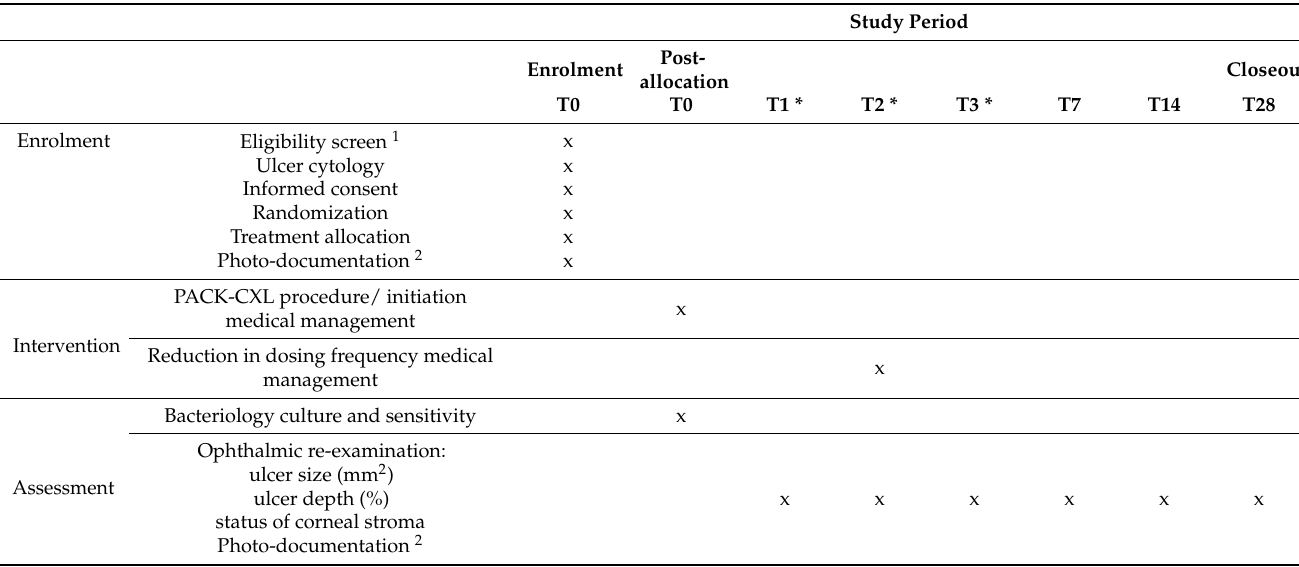
Table 3. Schematic timeline including the standard protocol items as defined by the 2013 SPIRIT statement.